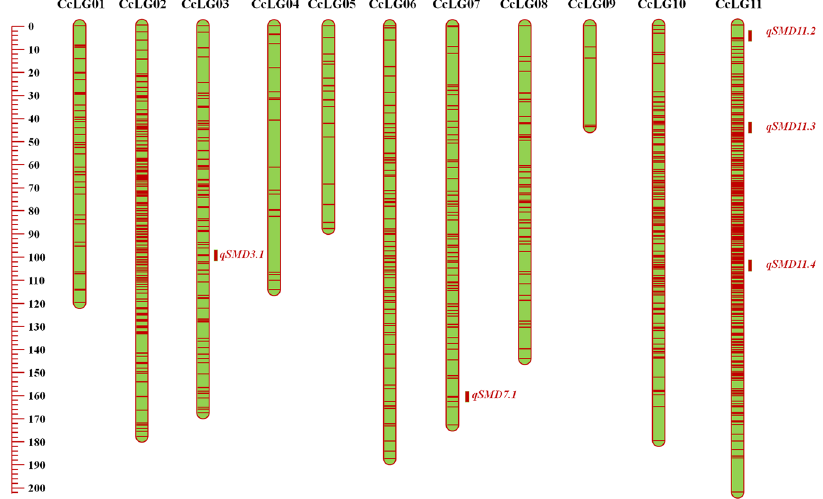
Figure 5. Genetic and QTL map constructed using 996 SNPs and of 1,596.30 cM length in ICP 8863 × ICPL 87119 (F 2 ) population in pigeonpea. The scale on left side represents map distance in cM. The eleven linkage groups are shown as vertical bars and each horizontal line on the bar represent single SNP marker.